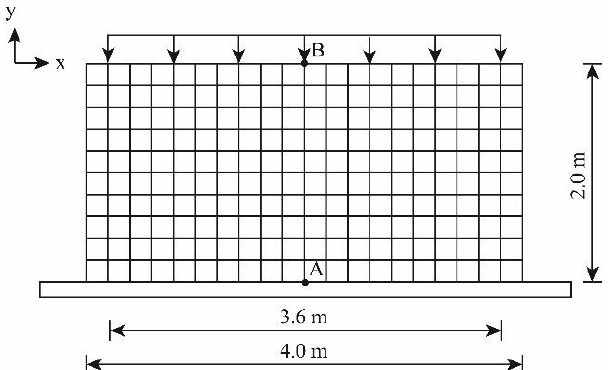
Figure 3. Geometry of contact between an elastic block and a rigid foundation, and finite element meshes.